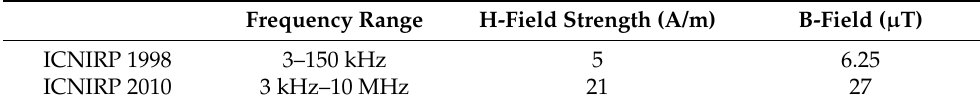
Table 1. Reference levels for general public exposure to time varying electric and magnetic